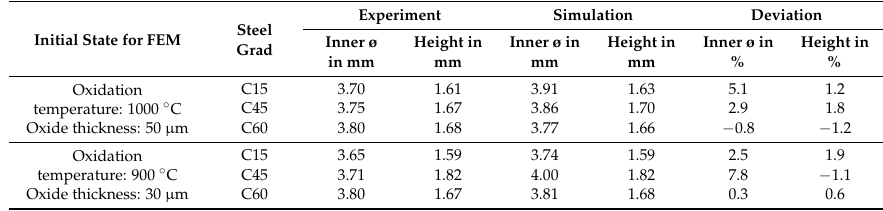
Table 9. Comparison of measured and simulated geometries of the ring-compression samples under different conditions.